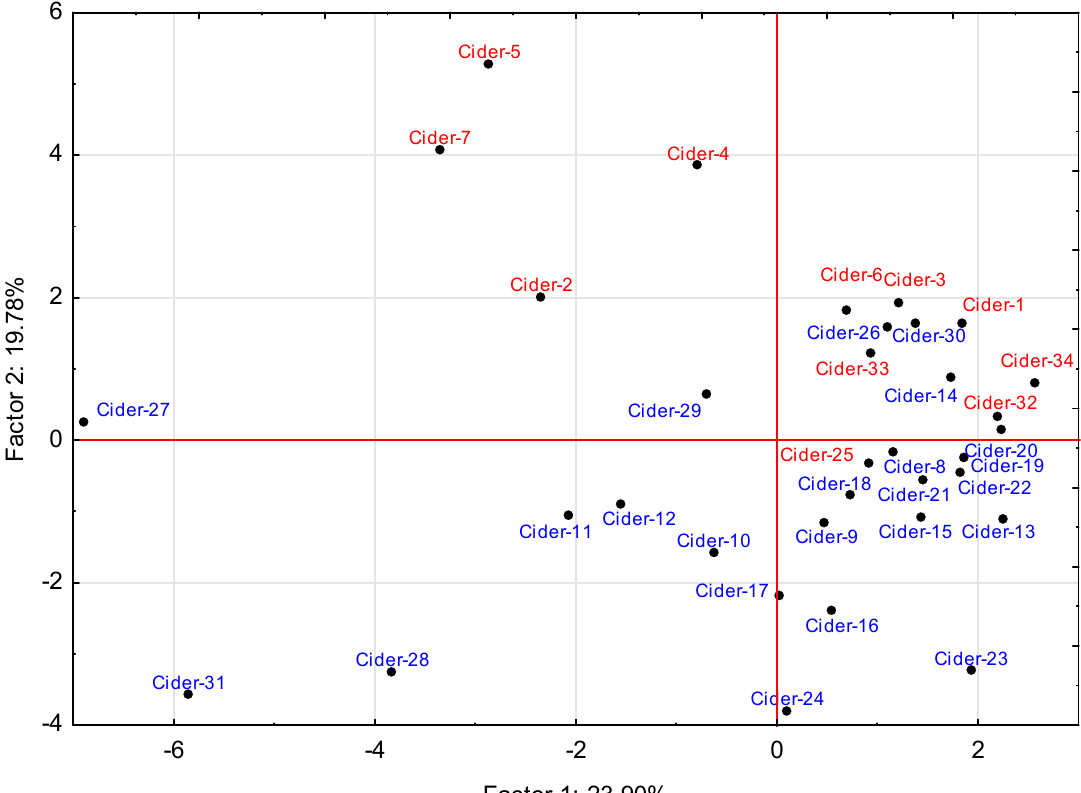
Figure 1. Principal component analysis of the ciders from classic (blue) and intensified production (red) based on Table 2.